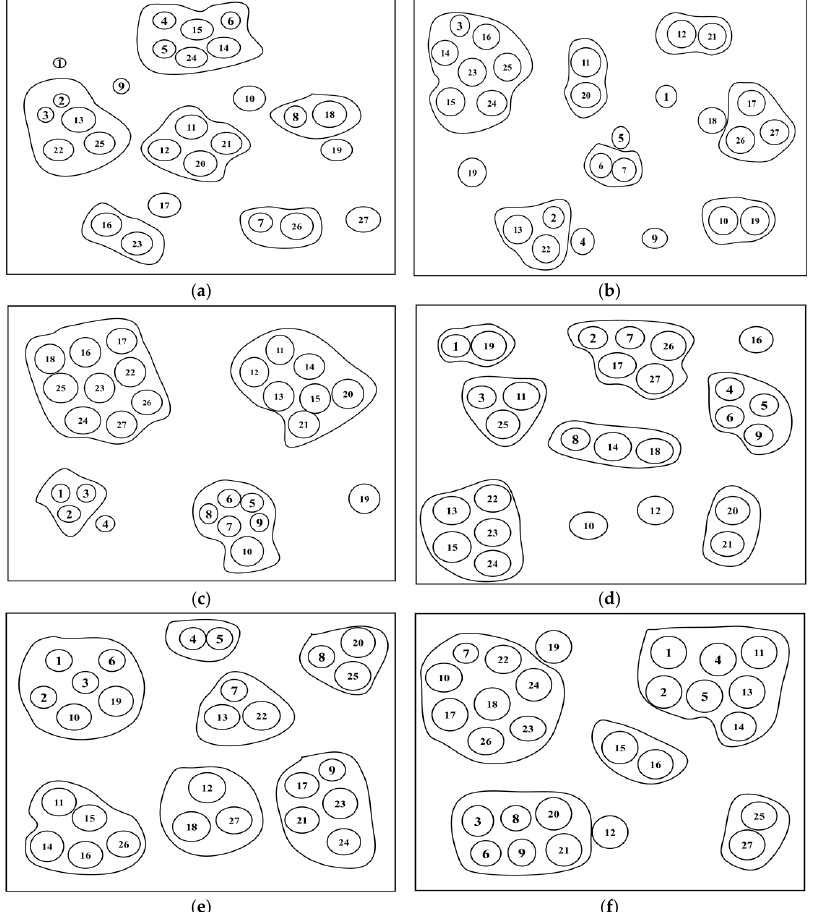
Figure 8. The groups of the phase dissimilarity of 6 evaluation indicators. ( a ) The groups of the phase dissimilarity of the runoff yield. ( b ) The groups of the phase dissimilarity of the sediment yield. ( c ) The groups of the phase dissimilarity of the TN content in runoff. ( d ) The groups of the phase dissimilarity of the TP content in runoff. ( e ) The groups of the phase dissimilarity of the TN content in sediment. ( f ) The groups of the phase dissimilarity of the TP content in sediment.